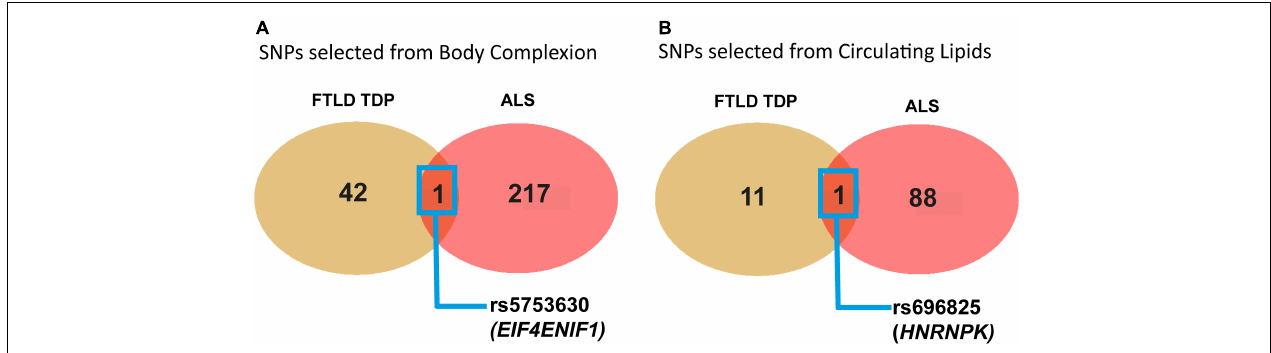
FIGURE 7 | Graphical representation of the identification of common significant SNPs in relation to body complexion and circulating lipids shared between FTD TDP43 subtype and ALS. (A) Venn diagram showing the common significant SNPs between FTLD TDP subtype and ALS from the 9 traits in relation to the body complexion group. The only genetic variant found in common is rs5753630, with EIF4ENIF1 as near gene. (B) Venn diagram showing the common significant SNPs between FTD and ALS from the 9 traits in relation to the circulating lipid traits. The only genetic variant found in common is rs696825 that falls in the 3 (cid:48) UTR of the HNRNPK